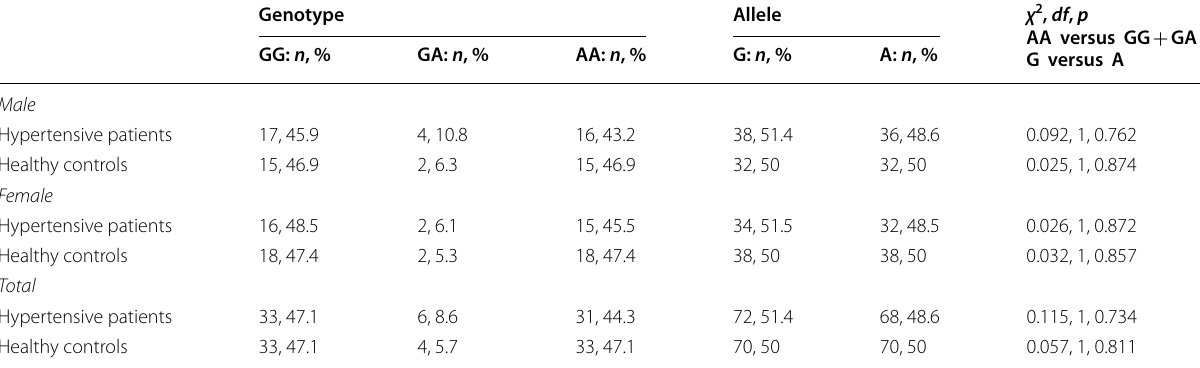
Table 4 Genotype and allele frequencies for the PT G20210A (rs1799963) polymorphism among groups Genotype